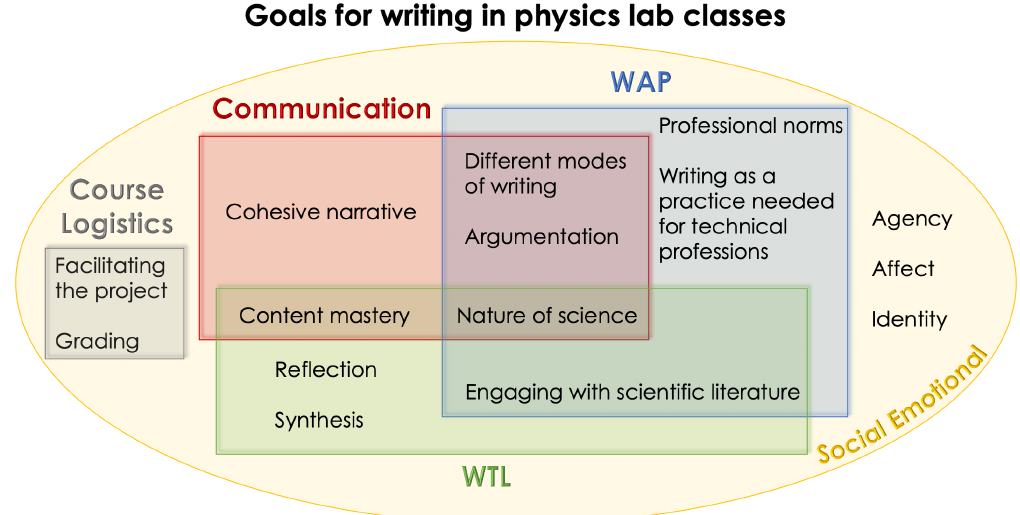
FIG. 1. Framework for thinking about and understanding the role of writing in physics lab classes. There are fifteen goals organized into five overlapping categories. Adapted from Ref.